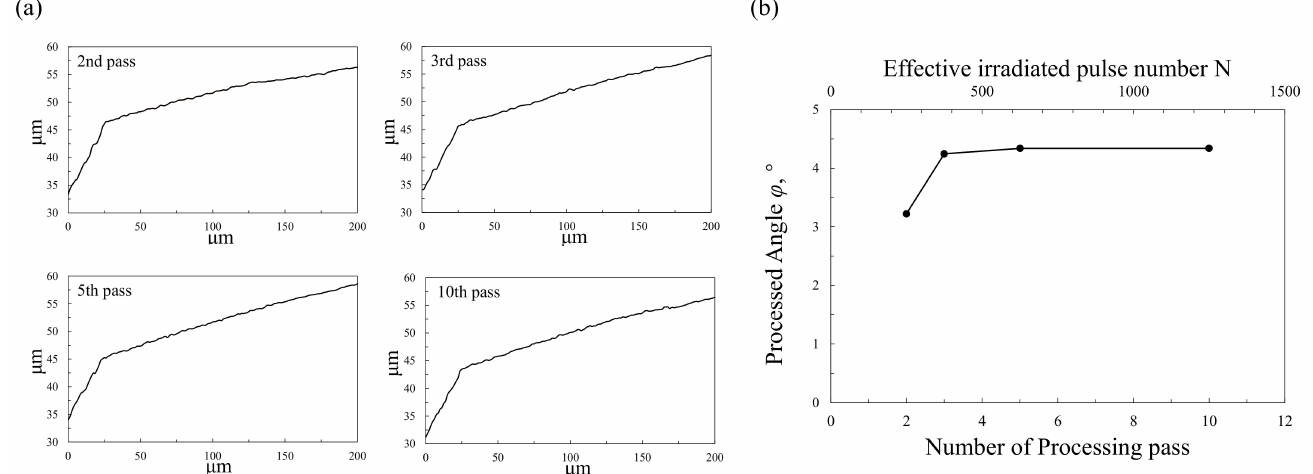
Figure 12. ( a ) Cross-sectional profile perpendicular to the laser scanning direction and ( b ) processed angle for PLG at a pulse pitch of 0.2 µ